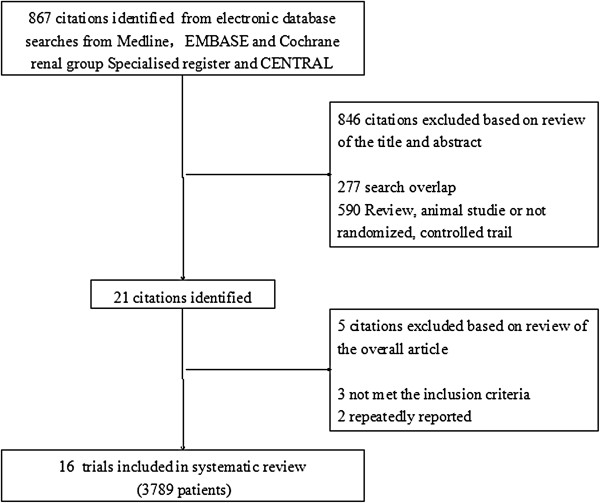
Procedure used for the trial selection.